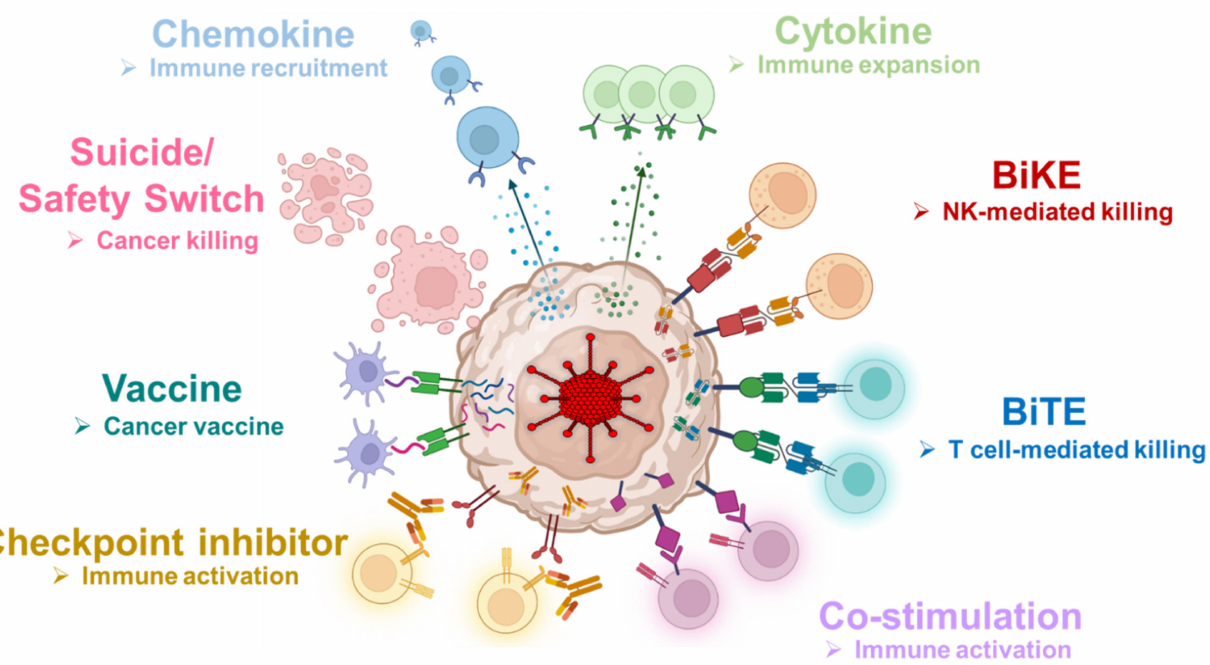
Figure 6. Concept of the HydrAd platform. The large transgene capacity of the HDAd enables the simultaneous expression of multiple immunomodulatory transgenes. The HydrAd platform can be adapted and customized as needed to overcome the specific challenges of various solid tumor